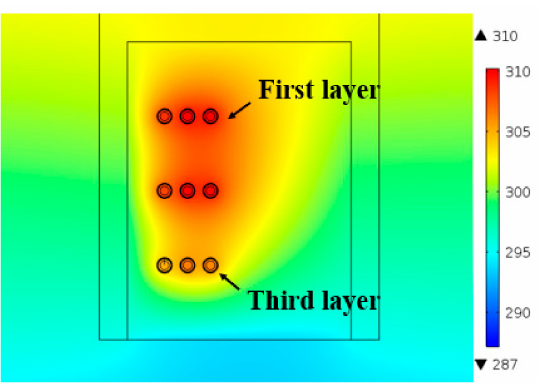
Figure 4. Temperature field distribution in cable trench (unit: K).